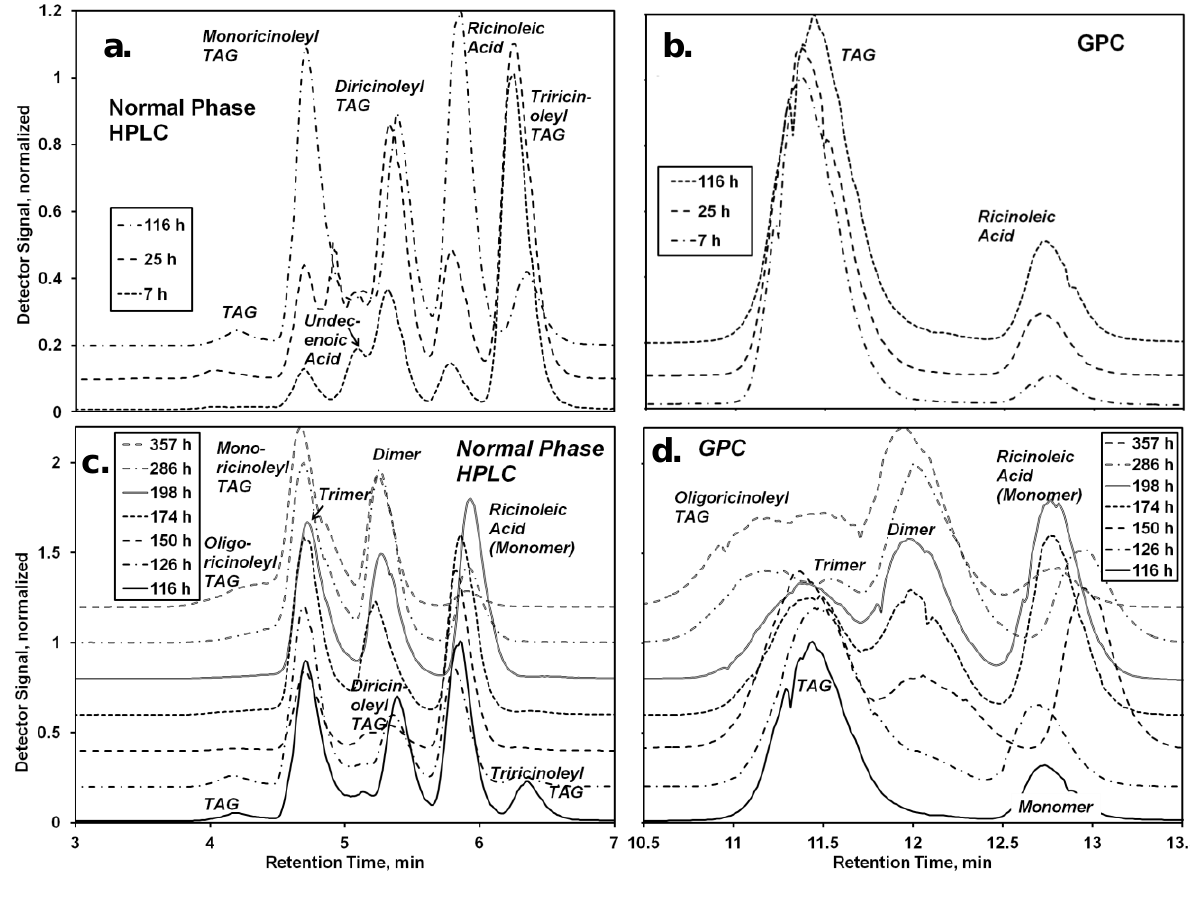
Figure 4. Analysis of the lipase-catalyzed synthesis of TAG containing oligo -ricinoleic acid and 10-undecenoic acid. ( a ) and ( b ) refer to the first step, the Rhizomucor miehei lipase (RML) -catalyzed acidolysis of castor oil with 10-undecenoic acid; ( c ) and ( d ) to the second step of the reaction, the CAL-catalyzed reaction between ricinoleic acid and the product from the first step. Chromatograms are from ( a , c ) normal phase HPLC and ( b , d ) GPC analyses. Reaction conditions: For the first step, castor oil (18.7 mg, 20.0 mmol) was mixed with 10-undecenoic acid (11.1 g, 60 mmol) and RML (9.5% w/w). The reaction mixture was held at 67 °C. After 116 h, the reaction was stopped; RML was removed by centrifugation, and CAL (5.8 wt %) was added. Additional ricinoleic acid (9.5 g, 32 mmol) was added 10 h, 34 h, and 58 h after the addition of CAL to the reaction mixture. The reaction was conducted at 72